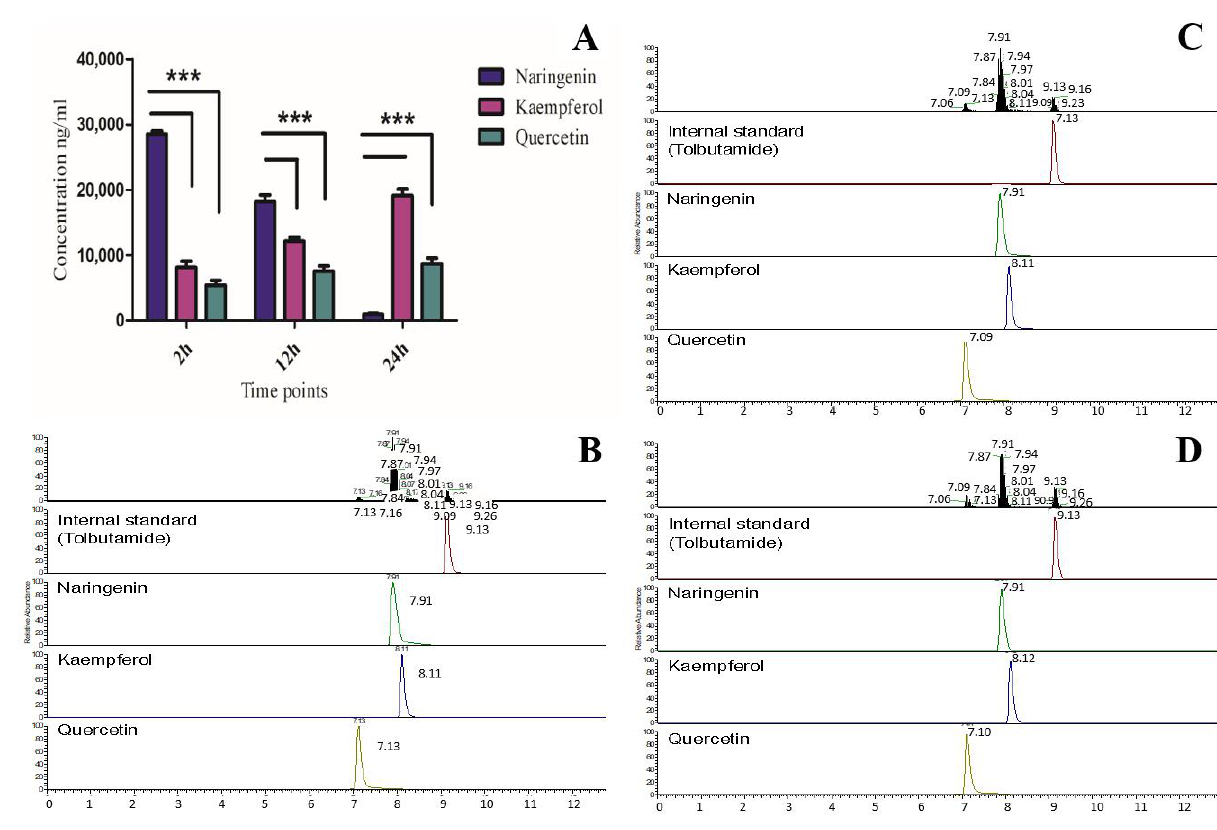
Figure 4. Analysis of naringenin conversion to kaempferol and quercetin using an engineered yeast system expressing the OsF3H gene by using LCMS-MS. ( A ) LCMS-MS profiling of naringenin, kaempferol and quercetin. Bars represent mean ± standard deviation, asterisks indicate significant difference ( p < 0.05 two-way ANOVA, Bonferroni post-test) between naringenin, kaempferol and quercetin after each time point. ( B – D ) extracted ion chromatograms of internal standard (naringenin, kaempferol and quercetin) in sample extracted after 2, 12 and 24 h induction, respectively, in OxF3H